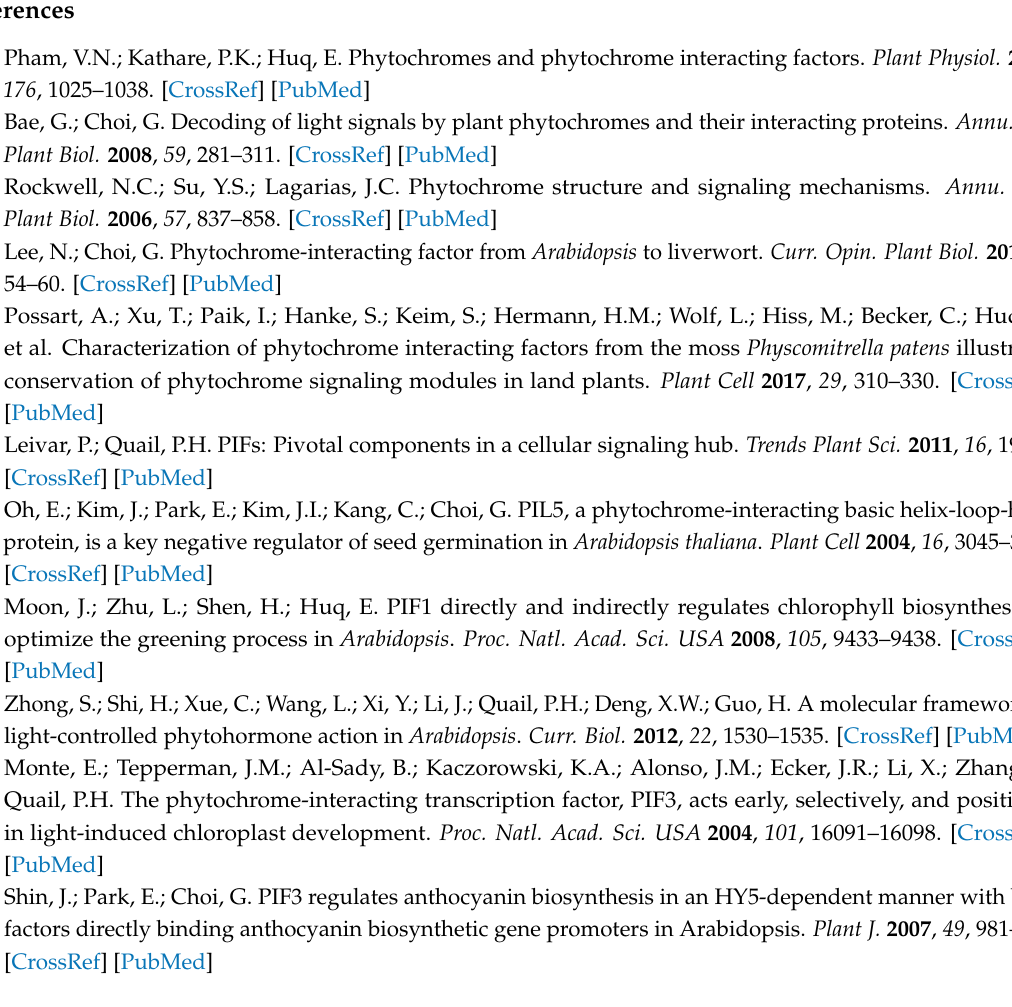
Table S1. Synteny regions of FIFs genes between grape and Arabidopsis thaliana , Solanum lycopersicum , Citrus sinensis , Figure S1. The amino acid sequence of PIFs motifs in MEME analysis, Figure S2. The interaction protein prediction of VvPIFs, Figure S3. Expression patterns of the grape PIFs family in different organs of ‘Corvina’, Figure S4. Expression patterns of the grape PIFs family in the leaves of ‘Cabernet Sauvignon’ under long or short term abiotic stress, Figure S5. Expression patterns of the PIFs family in the fruits of strawberry, citrus, and apple, Table S2. List of primer sequences used in qPCR analysis, Table S3. Prediction functional partners of PIFs and their